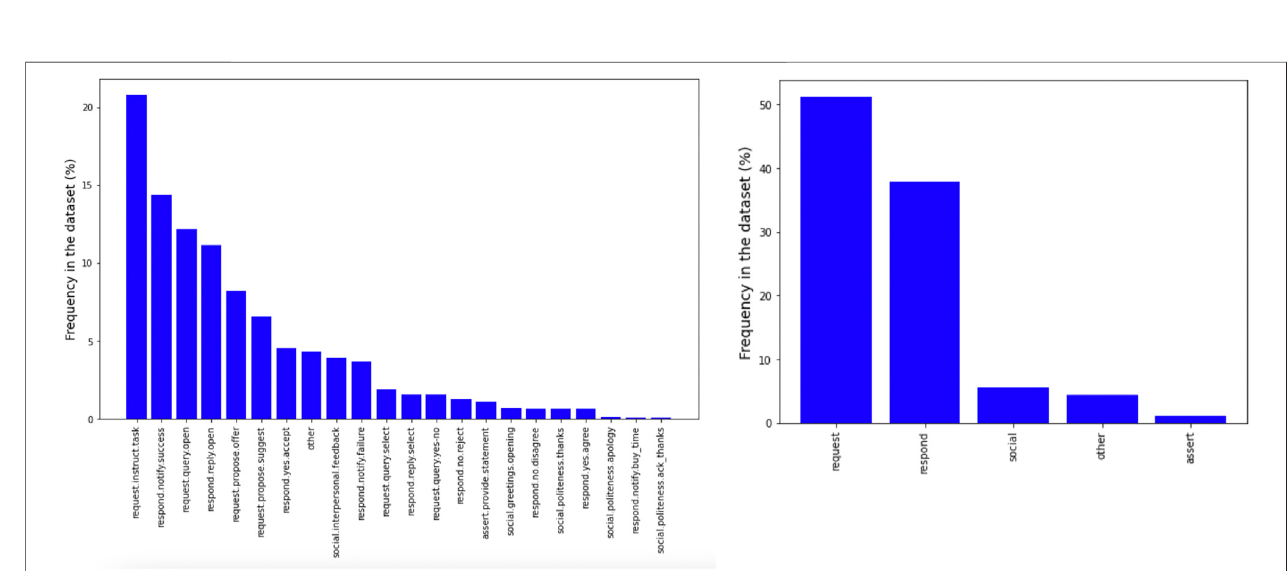
FIGURE 9 | Distribution of turn length in number of tokens for user and assistant turns in CROWDSS.